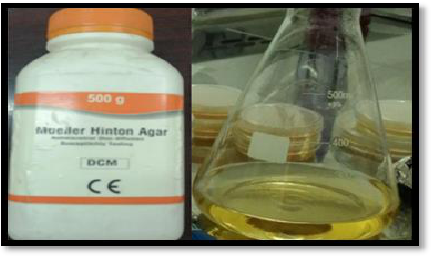
Figure 1: Optiglaze and Light cure unit Figure 2: Mueller-Hinton